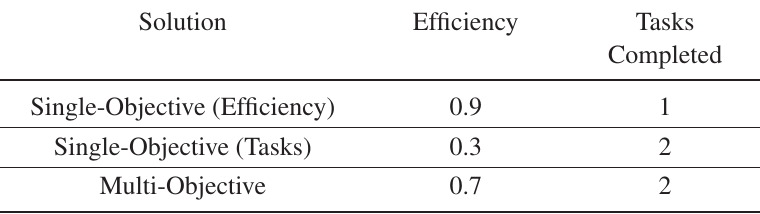
Table 6. Toy problem